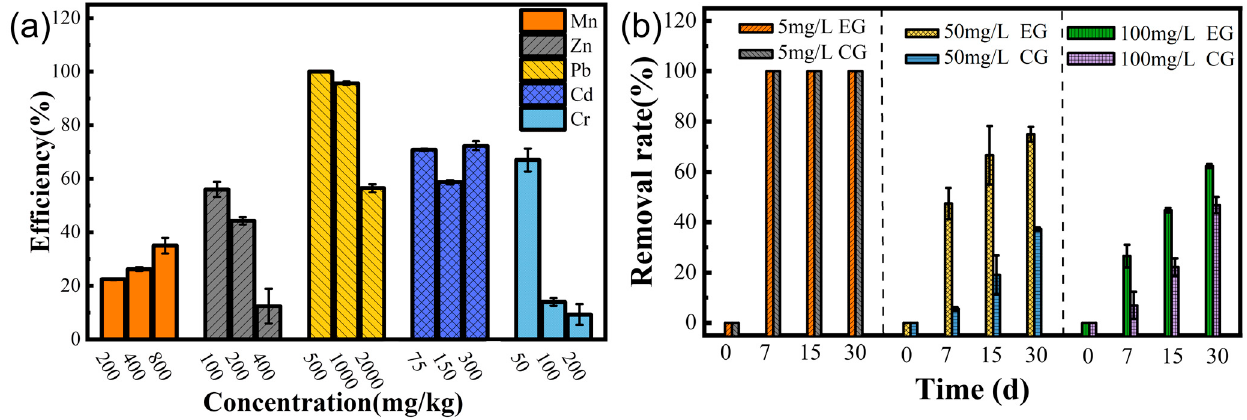
Figure 5. ( a ) Heavy metal removal rate of the LBA119 strain; ( b ) Bioremediation effect of the LBA119 strain on mercury-contaminated soil.